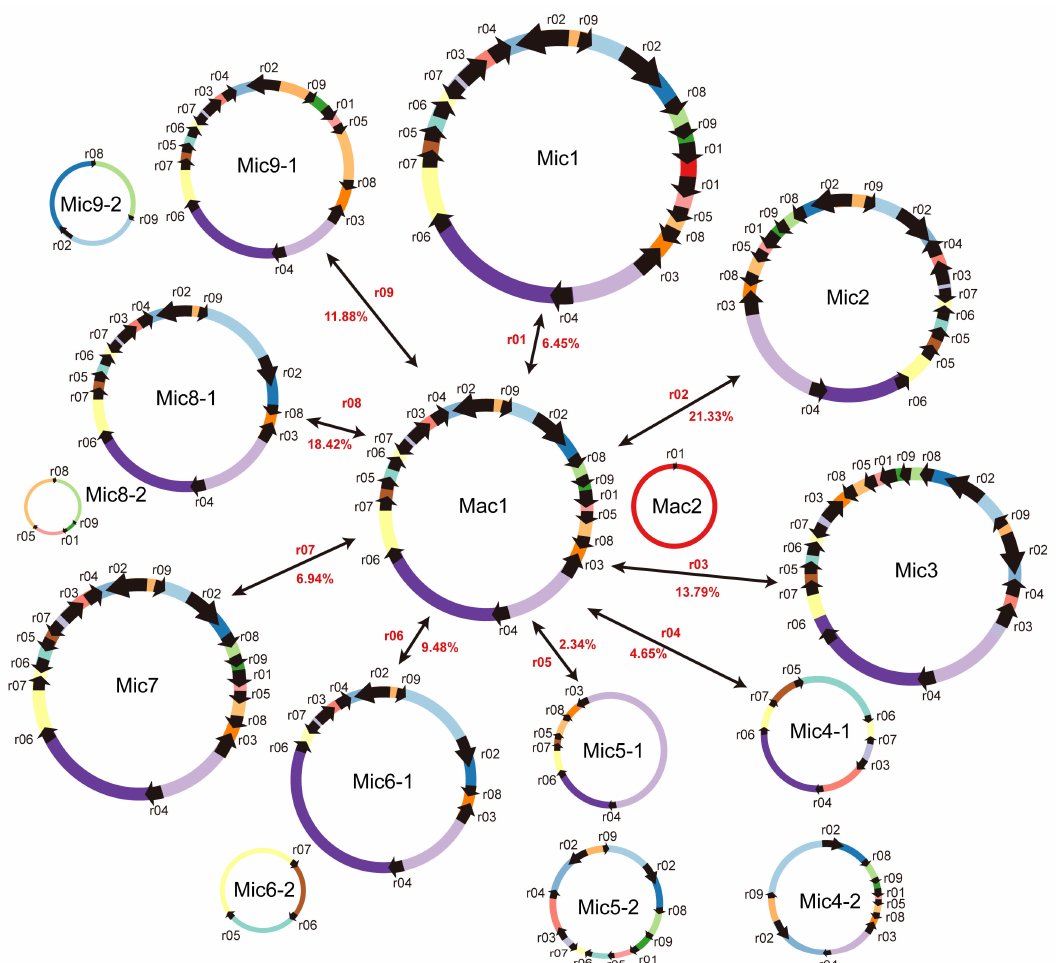
Figure 5. Potential conformations resulting from the recombination mediated by nine repeats (sami- r01 to sami-09) in the S. miltiorrhiza mitogenome. The black arrows on the circular molecules represent the repeat unit sequences, and the colored lines denote the DNA fragments between repeats. Mac and Mic represent the major and minor conformations resulting from the rearrangement, respectively. The dominant conformations included Mac1 and Mac2. Mic1 resulted from the sami- r01-mediated recombination with a recombination frequency of 6.45% and contained one circular molecule. Mic2, 3, and 7 resulted from r02, r03, and r07-mediated recombination from Mac1, respectively, with recombination frequencies of 21.33%, 13.79%, and 6.94%. They all contained one circular molecule. Mic4, 5, 6, 8, and 9 resulted from r04, r05, r06, sami-r08, and sami-r09-mediated recombination from Mac1, respectively, and their recombination frequencies were 4.65%, 2.34%, 9.48%, 18.42%, and 11.88%. They all split Mac1 into two Mic. r01 is an inter-molecular repeat and causes inter-chromosomal recombination. On the contrary, r02, r03, r04, r05, r06, and r07 lead to intra-chromosomal